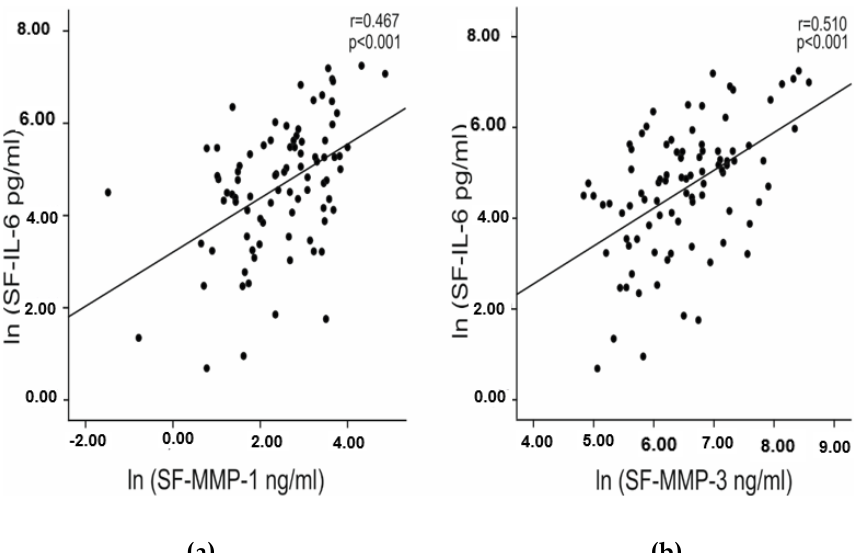
Figure 2. Correlation between IL-6 and MMP-1 ( a ) and MMP-3 ( b ) in patients with osteoarthritis. IL-6 and MMP levels in synovial fluid (SF) were measured by immunoassay. Natural logarithms (LN) of the SF concentrations of IL-6 and MMPs were calculated in order to have normally distributed variables for the Pearson correlation analysis. In the Figure, correlation coefficients (r) and p values are given. Synovial fluid samples were collected from 100 patients with knee OA [BMI 29.7 (8.3) kg/m 2 , age 72 (14) years, median (IQR); 62/38 females/males].